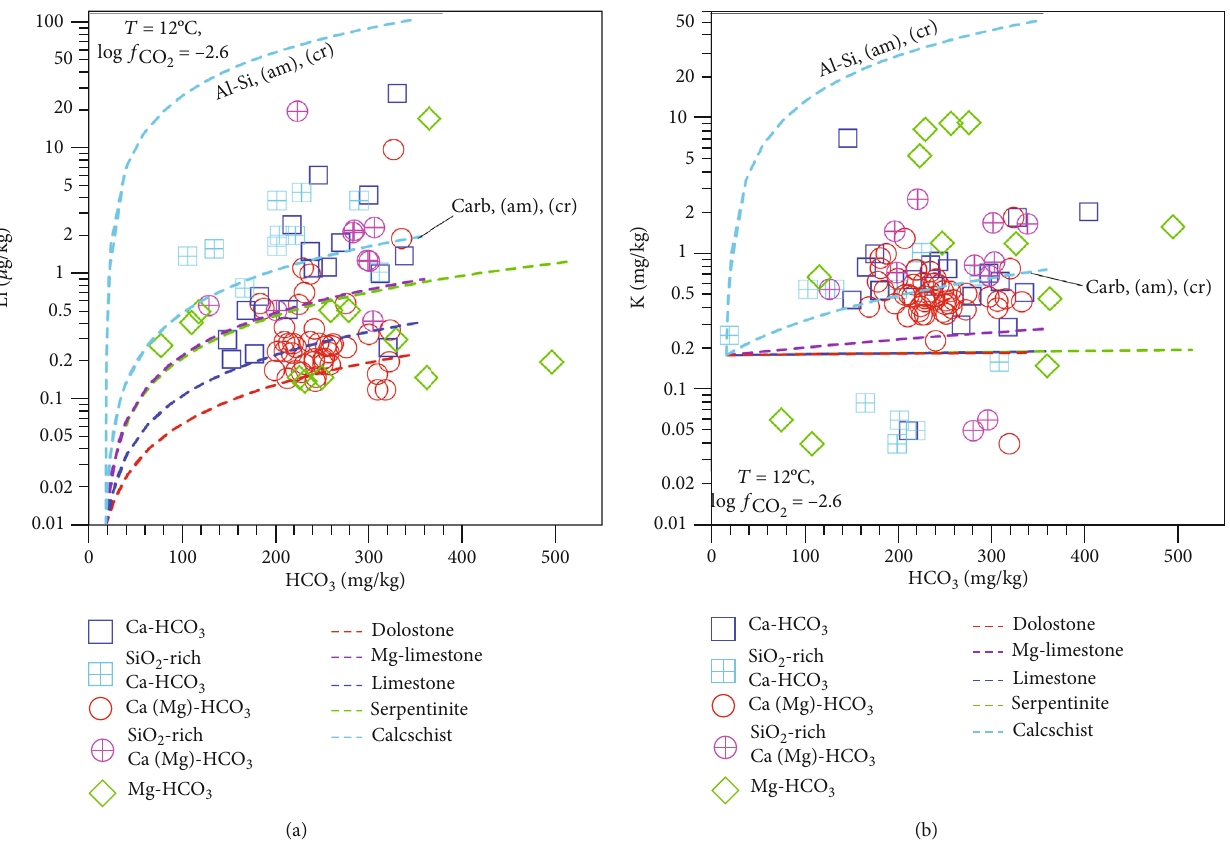
Figure 7: Correlation diagrams of alkalinity (expressed in mg HCO of di ff erent rocks (see legend) according to the simulations elaborated in this